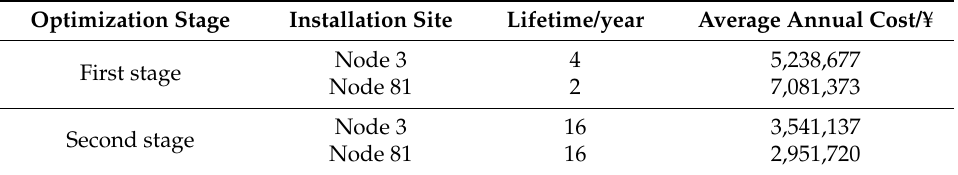
Table 2. Configuration results of the second-stage optimization.